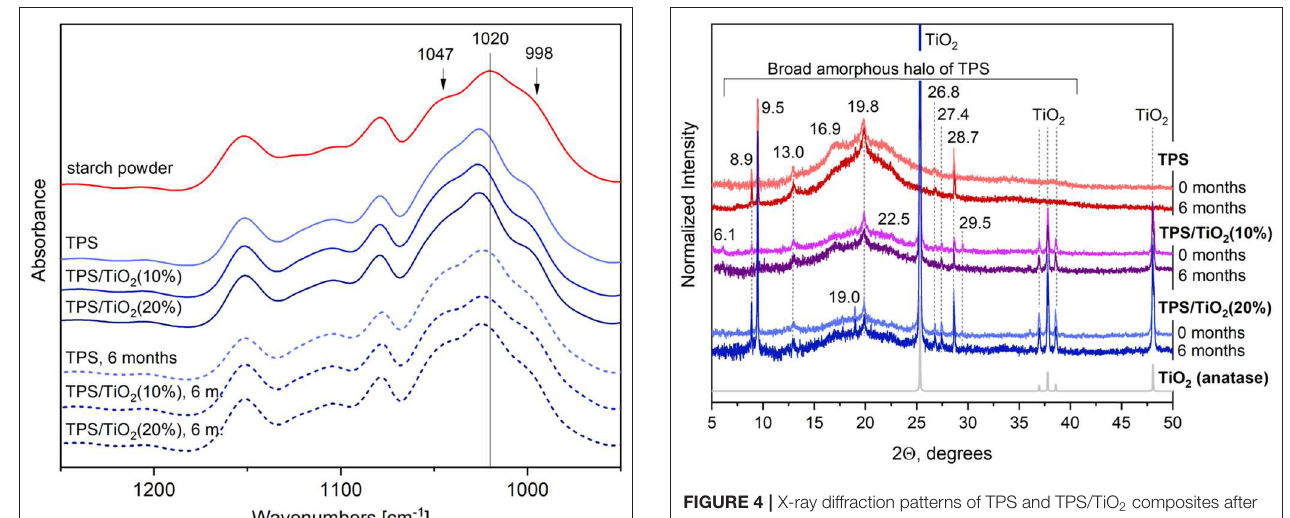
FIGURE 4 | X-ray diffraction patterns of TPS and TPS/TiO 2 composites after preparation and after 6 months of aging. The diffraction pattern at the bottom is theoretically calculated diffractogram of anatase modification of titanium dioxide. The peaks of TPS are marked with their 2 θ